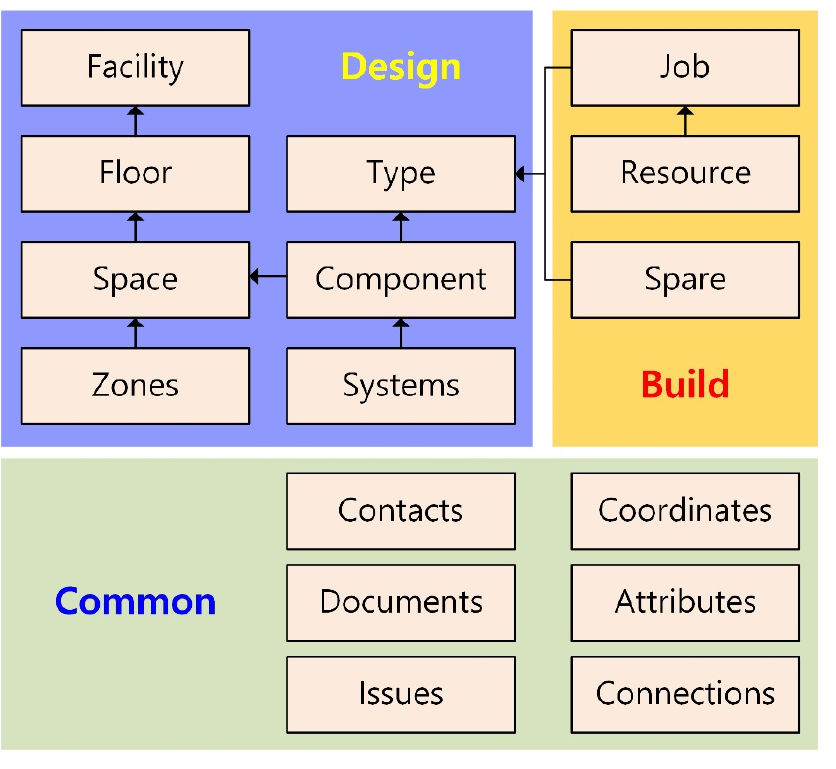
Figure 2. COBie data structure (Adapted from East William, 2007).